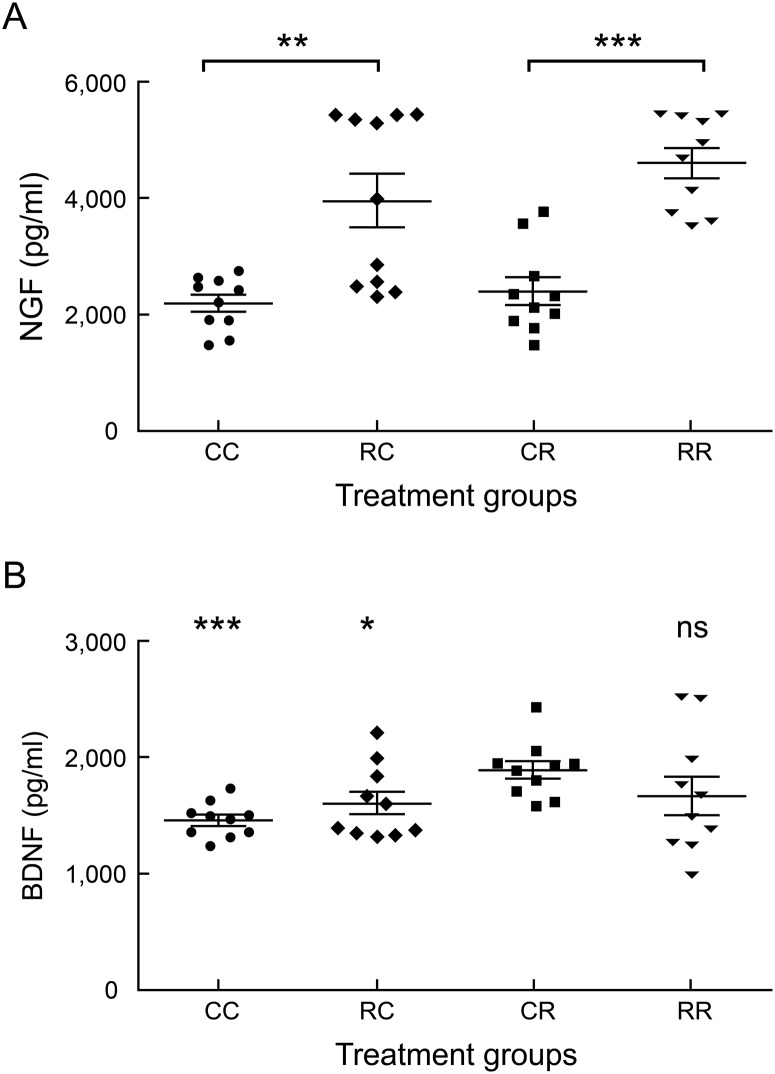
Prenatal rrRSV exposure is associated with increased postnatal NGF expression.(A) Maternal rrRSV infection significantly increased NGF expression in offspring compared to RSV-naïve controls both in the presence (RR vs. CR) and absence (RC vs. CC) of postnatal rrRSV LRTI. (B) BDNF levels did not increase because of prenatal rrRSV exposure, regardless of postnatal rrRSV LRTI status (CC vs. RC or RR), whereas postnatal rrRSV inoculation was associated with significantly increased BDNF in the absence of prenatal rrRSV exposure (CR vs. CC). Data for 3 experiments were combined and expressed as the mean ± SEM of 10 rats per group. Two-tailed student’s t test: *P<0.05, **P<0.01, ***P<0.001 as shown in Fig 6A or compared to the CR group in Fig 6B.